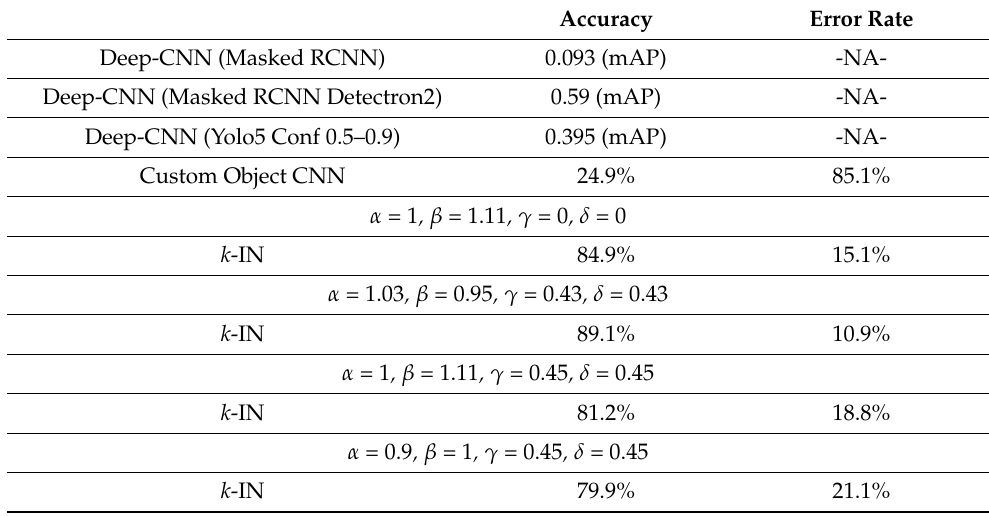
Figure 2 . ( a ) Collection of raw CT-scan image samples of carbonate rock. The samples are grayscale images. ( b ) Sample raw CT-scan images. ( c ) Pre-processed CT-scan image samples with already marked boundary with red color. Table 1. Comparing the accuracy of the proposed k -IN with that of the supervised deep-CNN approach. Here, we found the accuracy of the proposed approach outperforms the